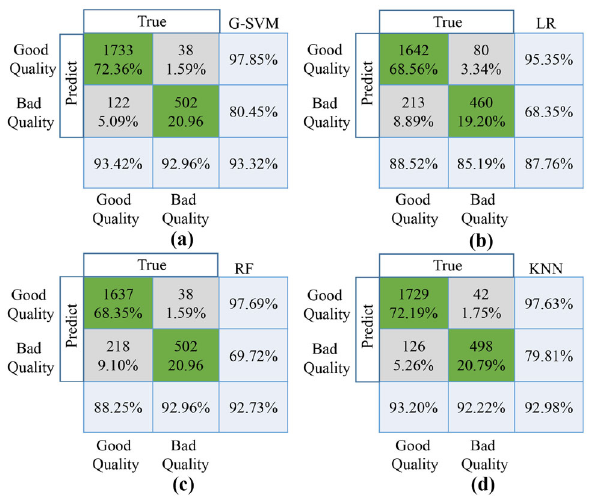
Fig. 8 Confusion matrices obtained by our DLDV feature on the four classifiers(G-SVM,LR,RFandKNN). a ConfusionmatrixonG-SVM. b Confusion matrix on LR. c Confusion matrix on RF. d Confusion matrix on